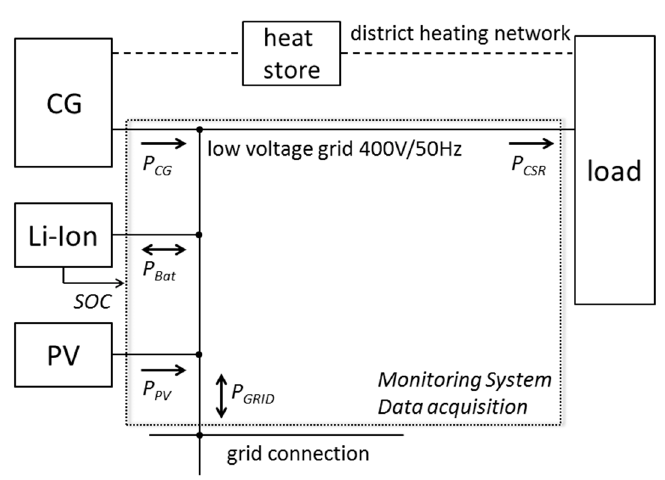
Figure 8. Architecture of the distributed power generation (DG).